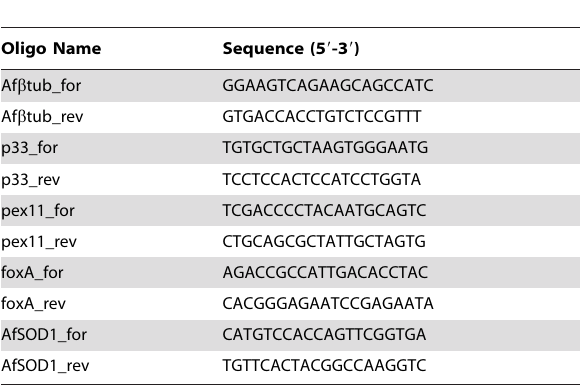
Table S2 Analysis of the effect of P33 on different